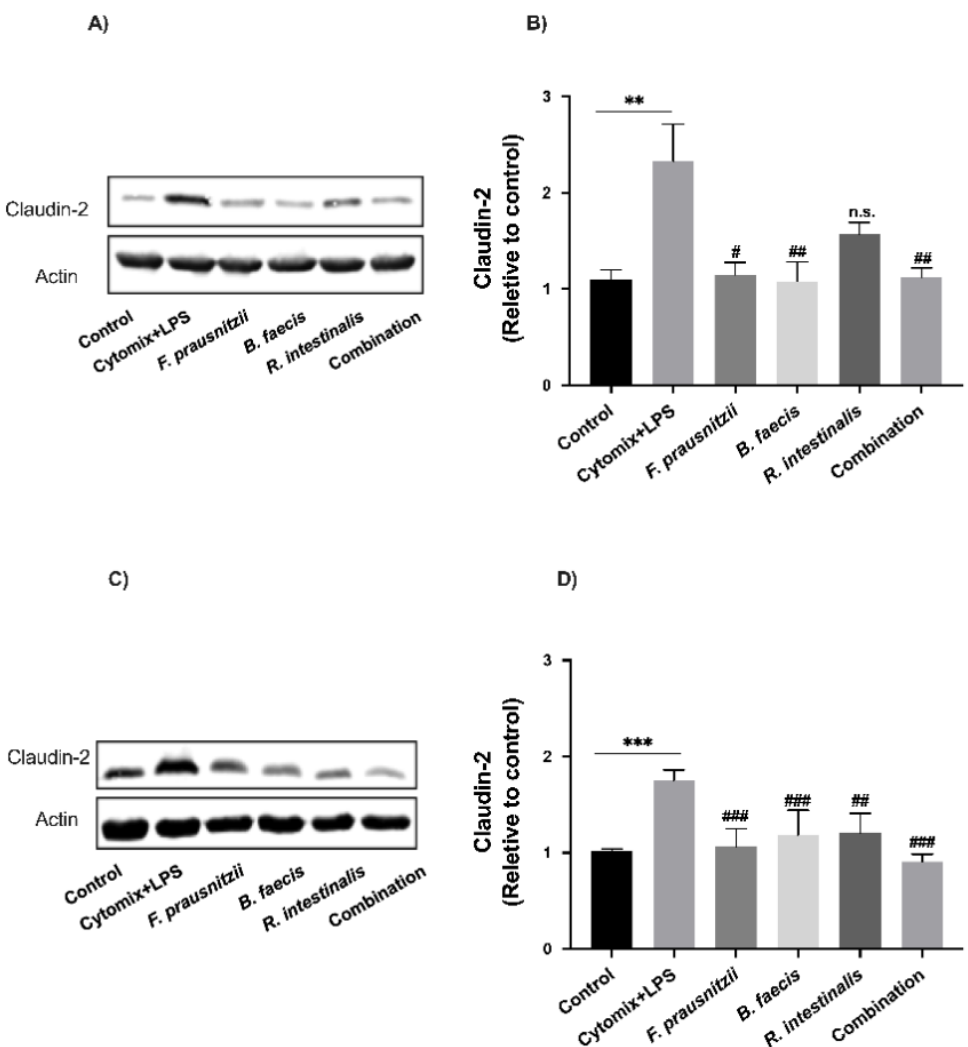
Figure 7. Effect of F. prausnitzii , B. faecis and R. intestinalis alone and in combination on claudin-2 expression. Representative claudin-2 immunoblot and the relative densities of Caco-2 ( A , B ) and HT29-MTX cells ( C , D ). The protein bands were quantified through densitometry analysis and normalized to the intensity of the β -actin bands. Data were shown as the mean ± SD of the three biological replicates ( n = 3). ** p ≤ 0.01 *** p ≤ 0.001 compared to the control group. # p ≤ 0.05, ## p ≤ 0.01, ### p ≤ 0.001, n.s., no significant compared to the cytomix + LPS group as determined by one-way